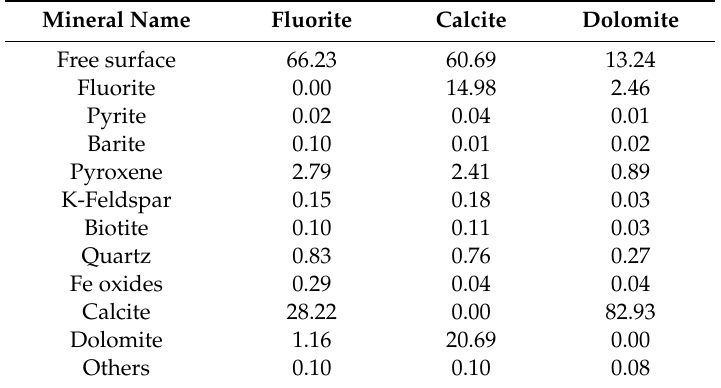
Table 8. Mineral associations between fluorite and gangue minerals in mass